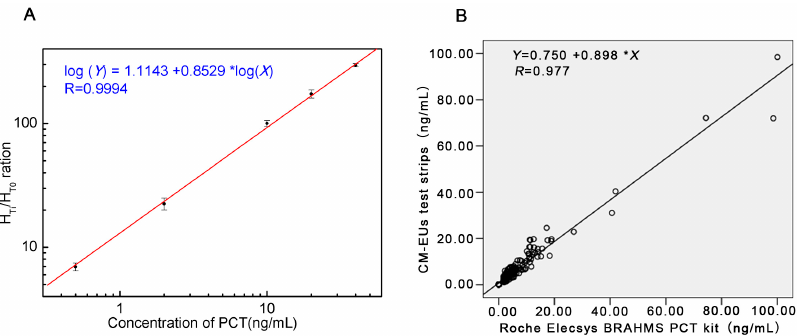
Figure 3. The standard curve and the results of correlation analysis. ( A ) Standard curve for PCT; ( B ) Comparison of PCT in 234 sera samples measured with the developed CM-EUs test strips and a Roche Elecsys BRAHMS PCT kit.